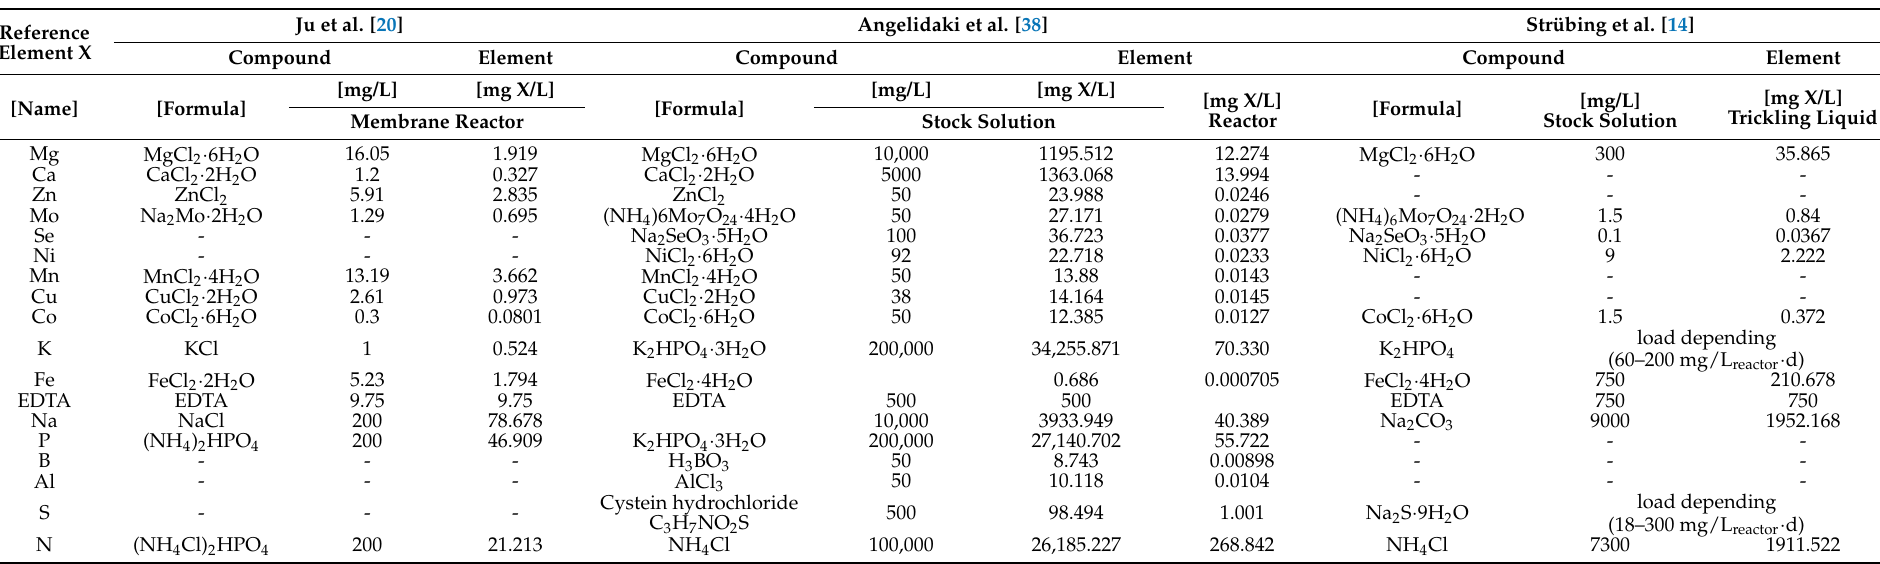
Table 2. Comparison of elements and compounds for dosing in the trickling liquid for three references Angelidaki, et al. [38], Ju, et al. [20], and Strübing, et al. [14]. Chemical compound and concentration of trace elements (mass referred to as element/compound X) in the stock solution and the reactor/trickling liquid in